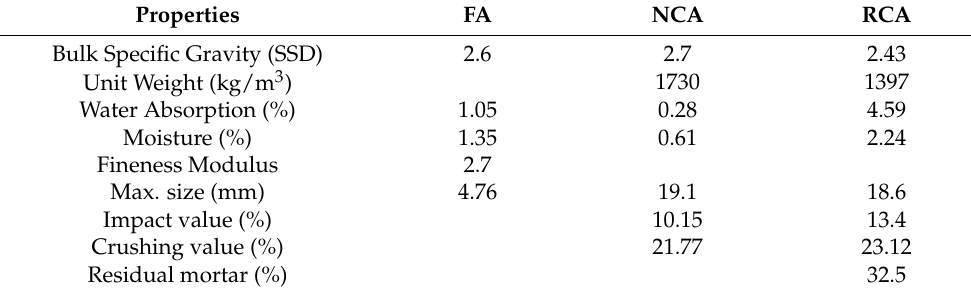
Table 1. Physical properties of fine, natural and recycled aggregates.